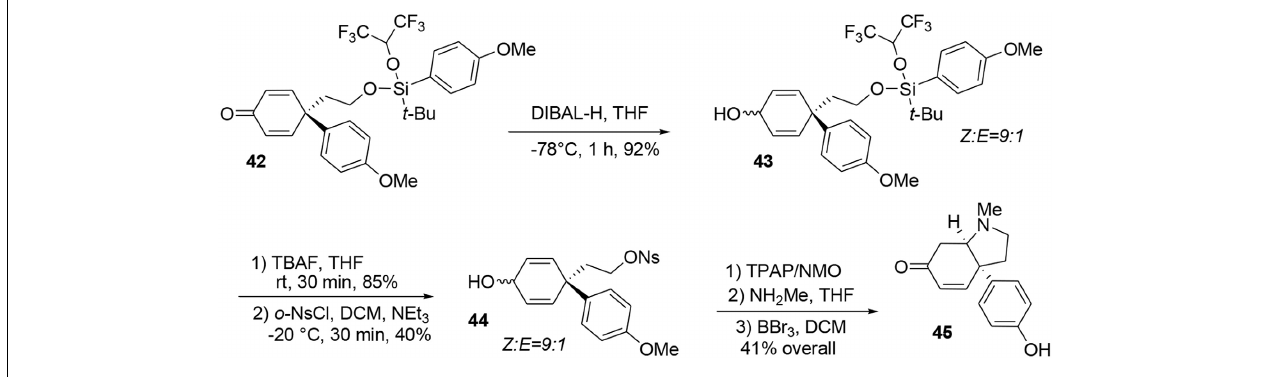
Scheme 12 | Final steps of sceletenone synthesis.